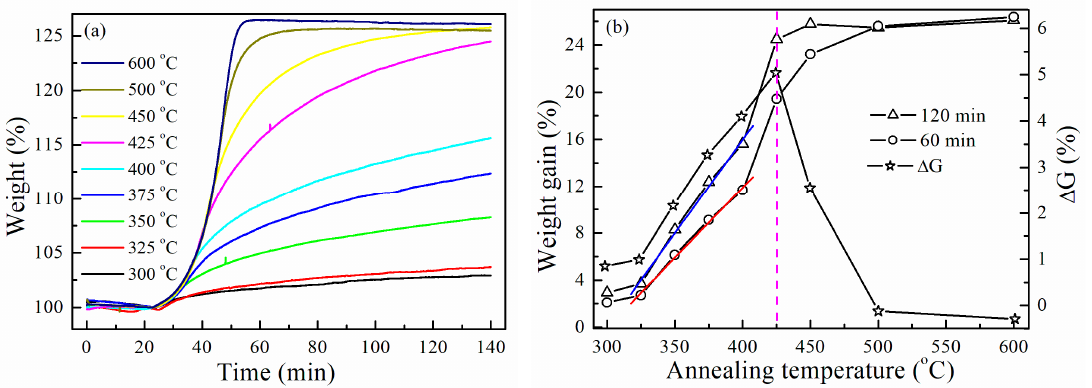
Figure 4. TGA curves of Ni NWs ( a ) and variation of weight gain and ∆ G ( b ) as a function of oxidation temperature.